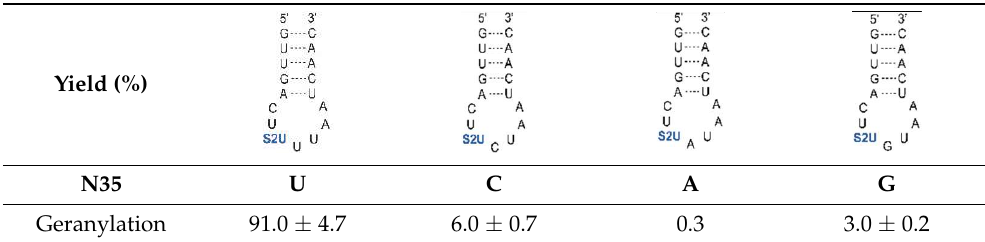
Table 2. MBP–SelU recognizes the nucleoside in the 35th position (N35) of the anticodon loop, the position next to the S2U modification.